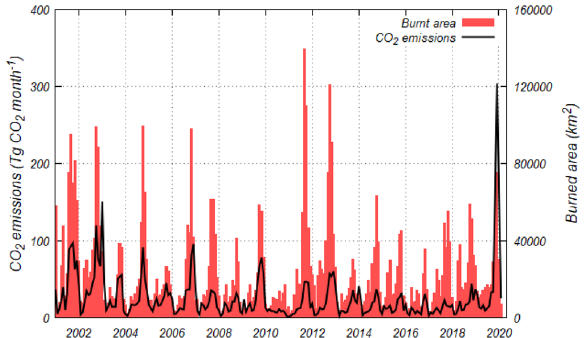
Figure 2. Monthly burnt area of LC–M and estimated CO 2 emissions in Australia from January 2001 to February 2020.